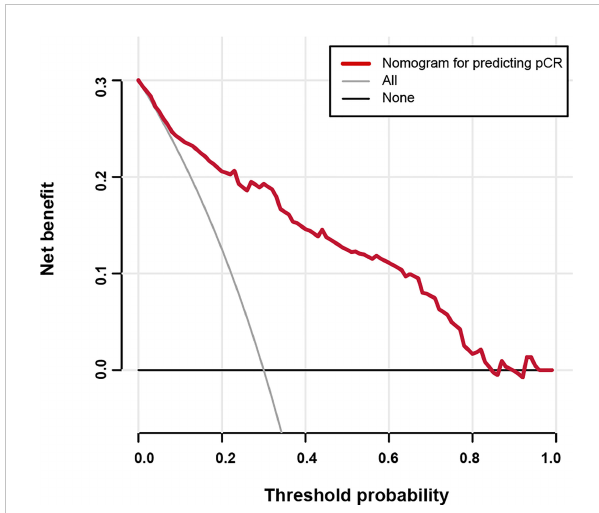
FIGURE 4 Decision curve analysis for the nomogram predicting the possibility of pathological complete response.